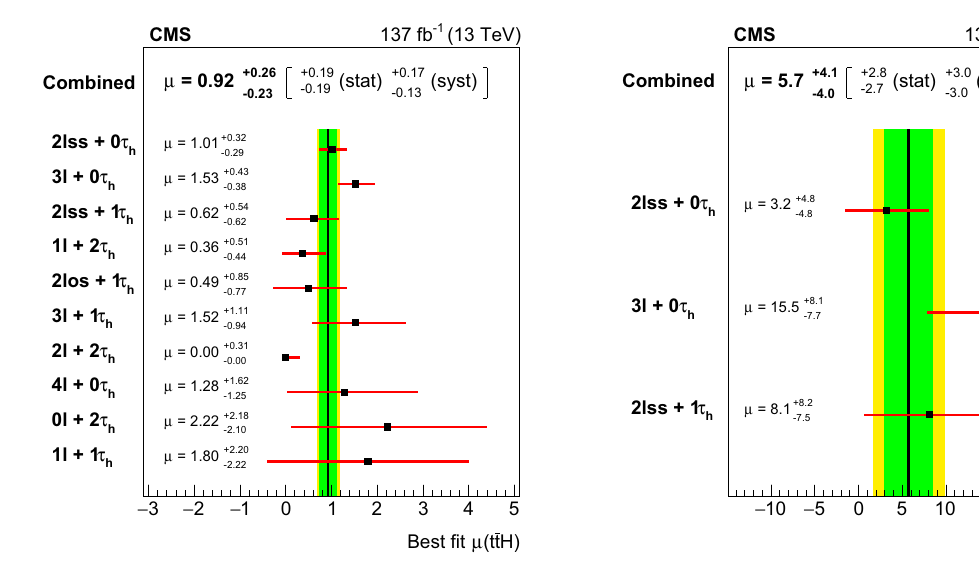
nation of all channels. The central value of the signal strength in the 2 (cid:4) + 2 τ h is constrained to be greater than